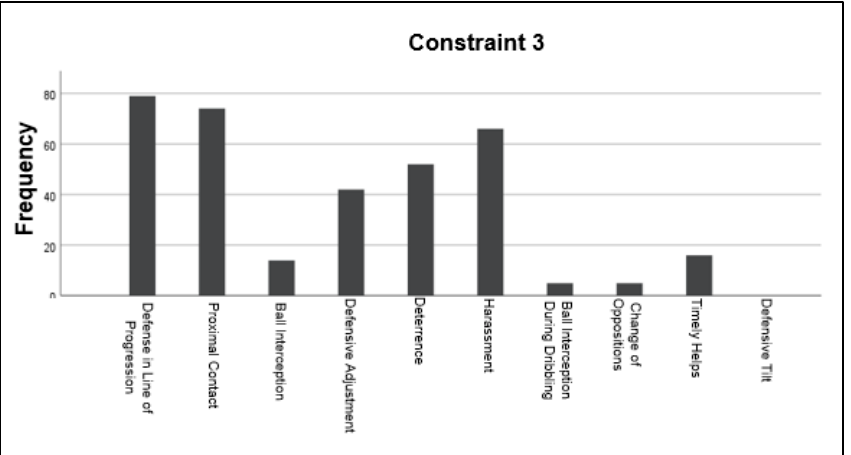
Figure 4. The frequency in which handball’s motor behaviors were activated during the exercise where constraint 3 (One attacker with one ball plus one pivot) was applied.